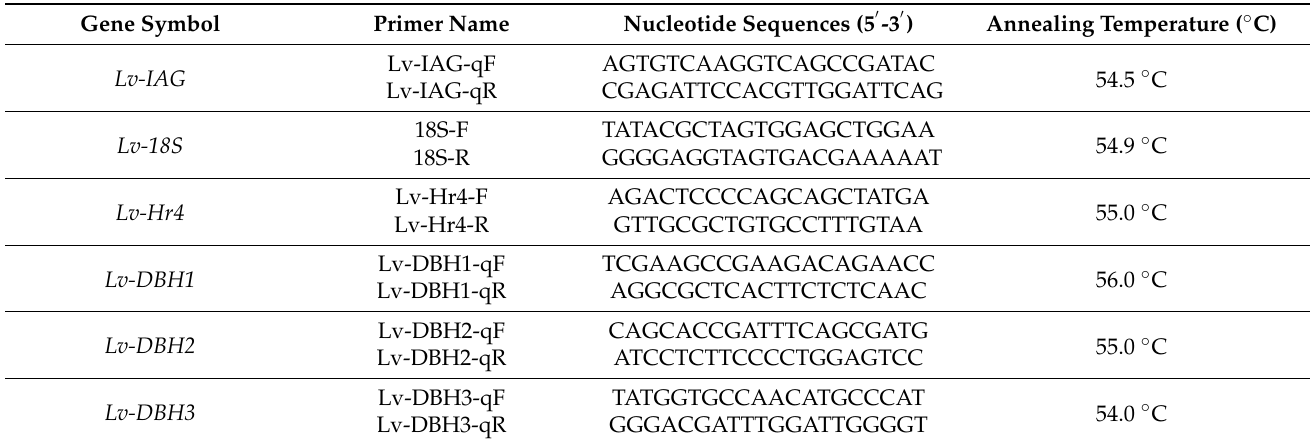
Table 3. All primers used in this